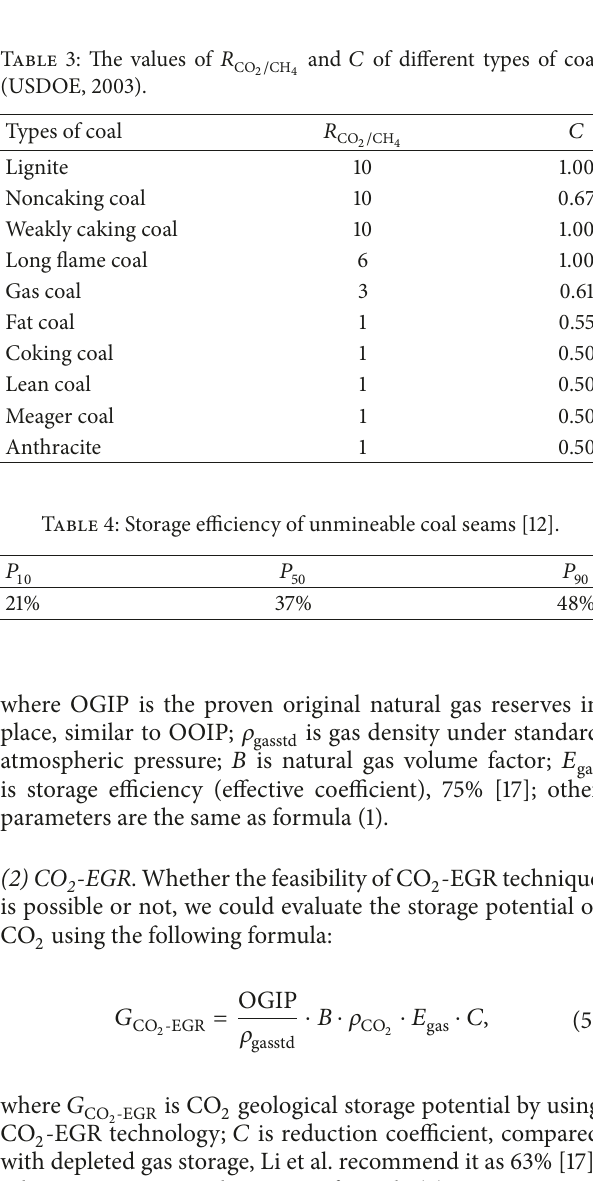
Table 5: CO 2 storage efficiency coefficients 𝐸